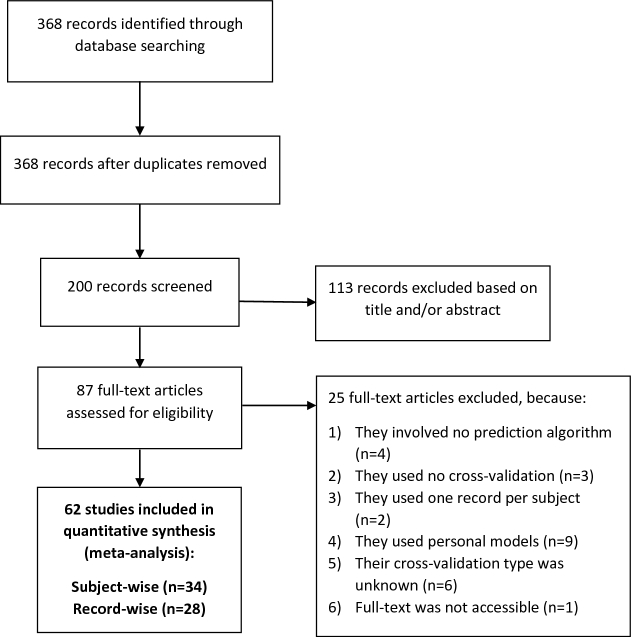
PRISMA flowchart.